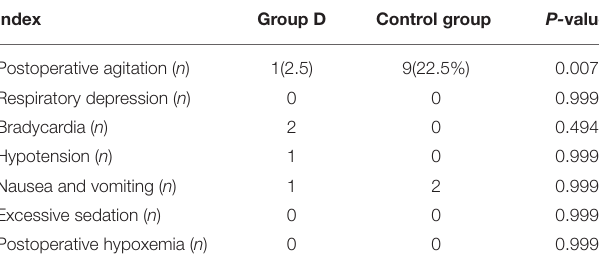
TABLE 2 | Adverse events of children ( n = 40).